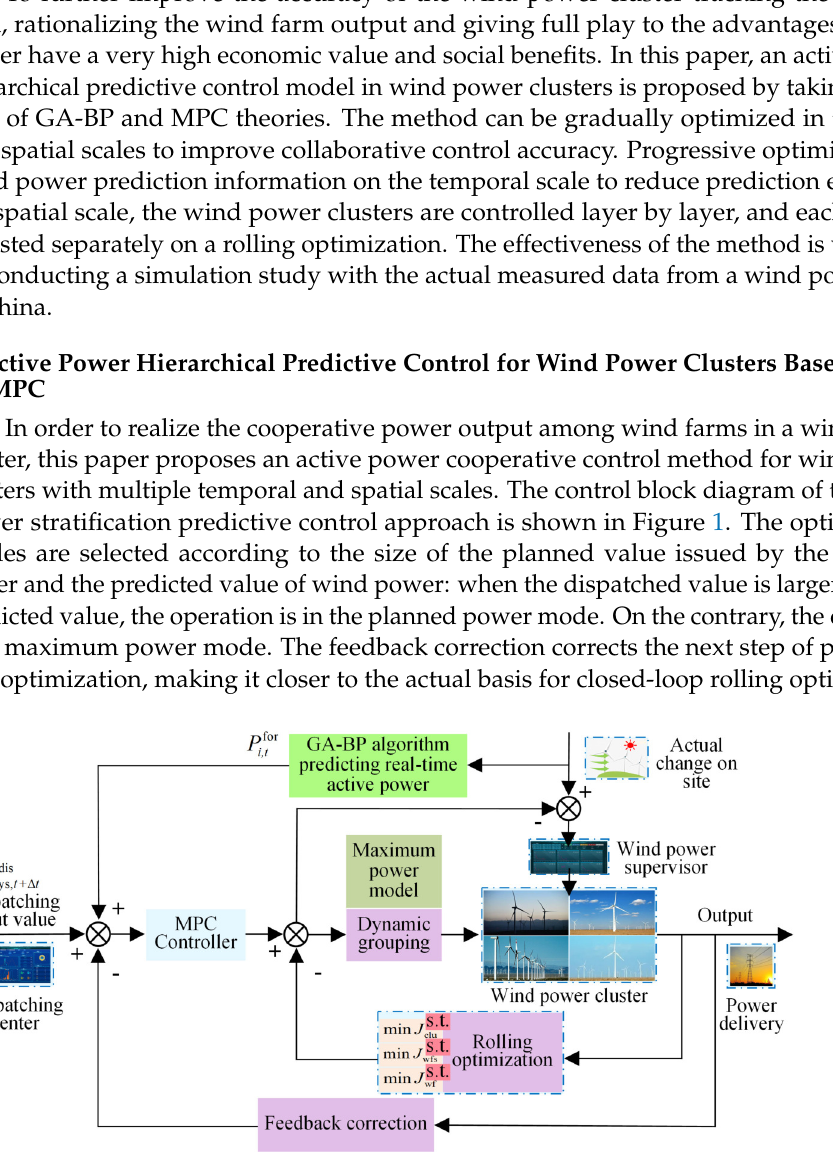
Figure 1. Control block diagram of active power stratification predictive control